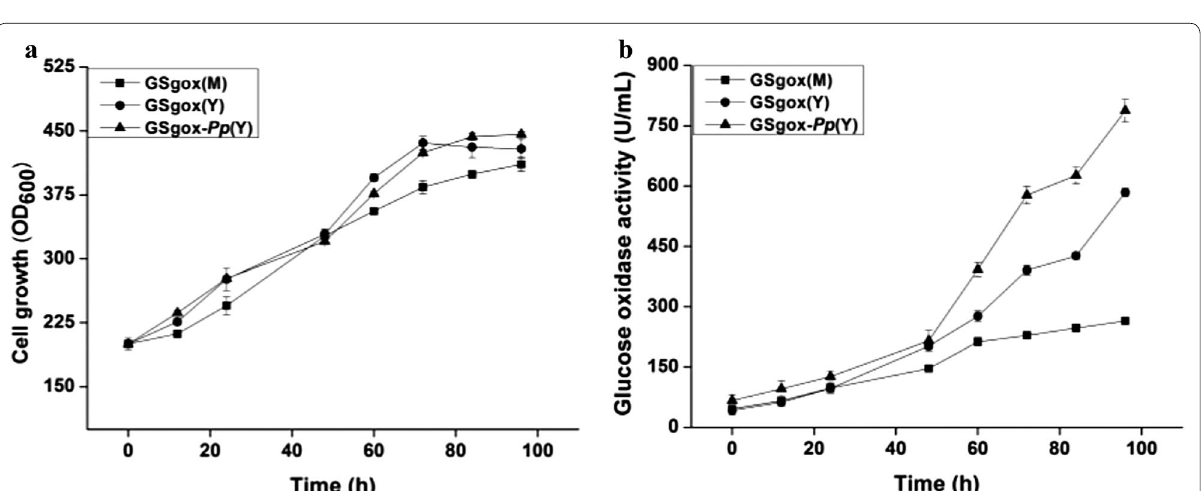
Fig. 5 Synergistic effect of Hac1p and YE co-feeding on Gox production in a 1-L fermenter. a Cell growth. b Glucose oxidase activity. GSgox with sole methanol feeding (square), GSgox co-fed with yeast extract (circle), GSgox- Pp co-fed with yeast extract